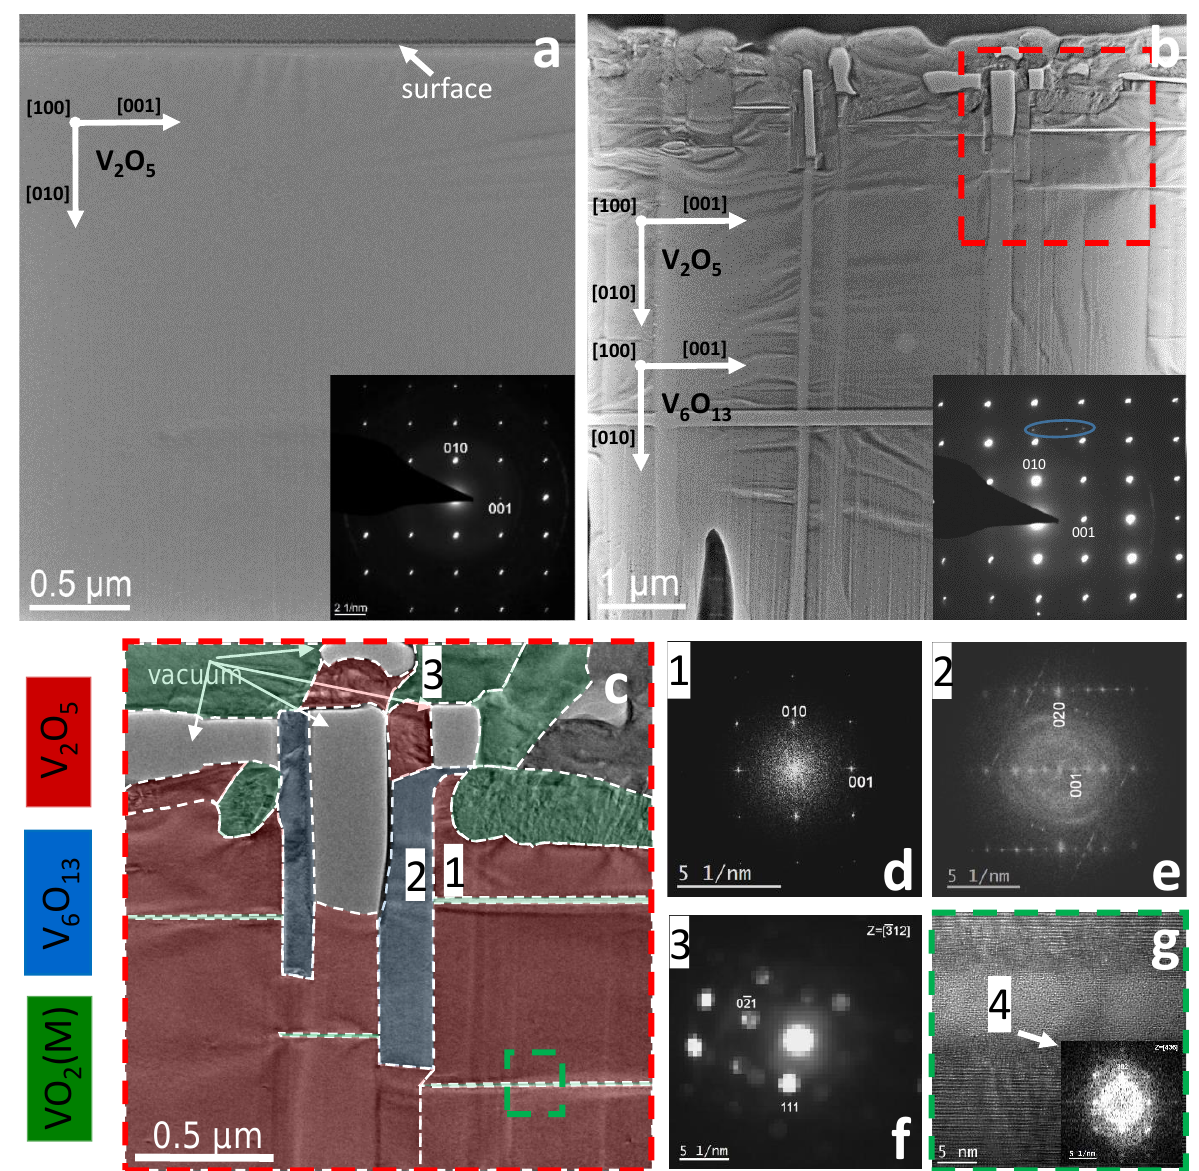
Figure 6. Structure of the vanadium pentoxide crystal in ( a ) as-grown state and ( b – g ) after annealing at 800K for 16h at 10 − 5 mbar. ( a ) TEM image of the as-grown sample. ( b ) TEM overview image of the sample after annealing at 800K. Inserts in ( a , b ) show DPs from the entire sample and the orientation of the phases relative to the sample frame. ( c ) enlarged fragment of ( b ) indicated by the red dashed square; the colour of the image areas depends on the phase allocation; the colour code is at the bottom left of the figure. ( d , e ) FFTs from the HRTEM images of areas 1 and 2 in ( c ), which are determined to correspond to orthorhombic V 2 O 5 in 1 and monoclinic V 6 O 13 in 2 with zone axis parallel to [100] direction in each lattice. ( f ) nanobeam diffraction from the area 3 in the sample’s surface; the phase is concluded to be monoclinic VO 2 . ( g ) enlarged fragment of ( c ) indicated by the green dashed square; A thin well-defined strip is separated by crystalline V 2 O 5 . The FFT inset—corresponding to the thin strip—indicates it consists of monoclinic VO 2 and some amorphous material.